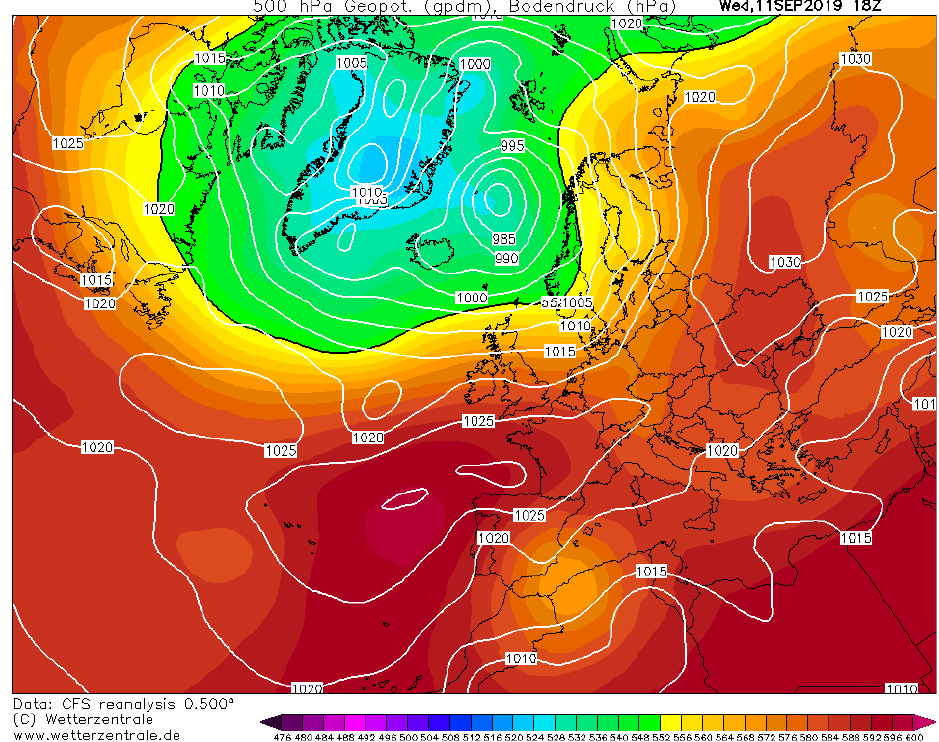
Figure 3. Atmospheric situation causing the cold front of 11th September 2019, with floods in the south-eastern part of the Iberian Peninsula. Source: Wetterzentrale [67].